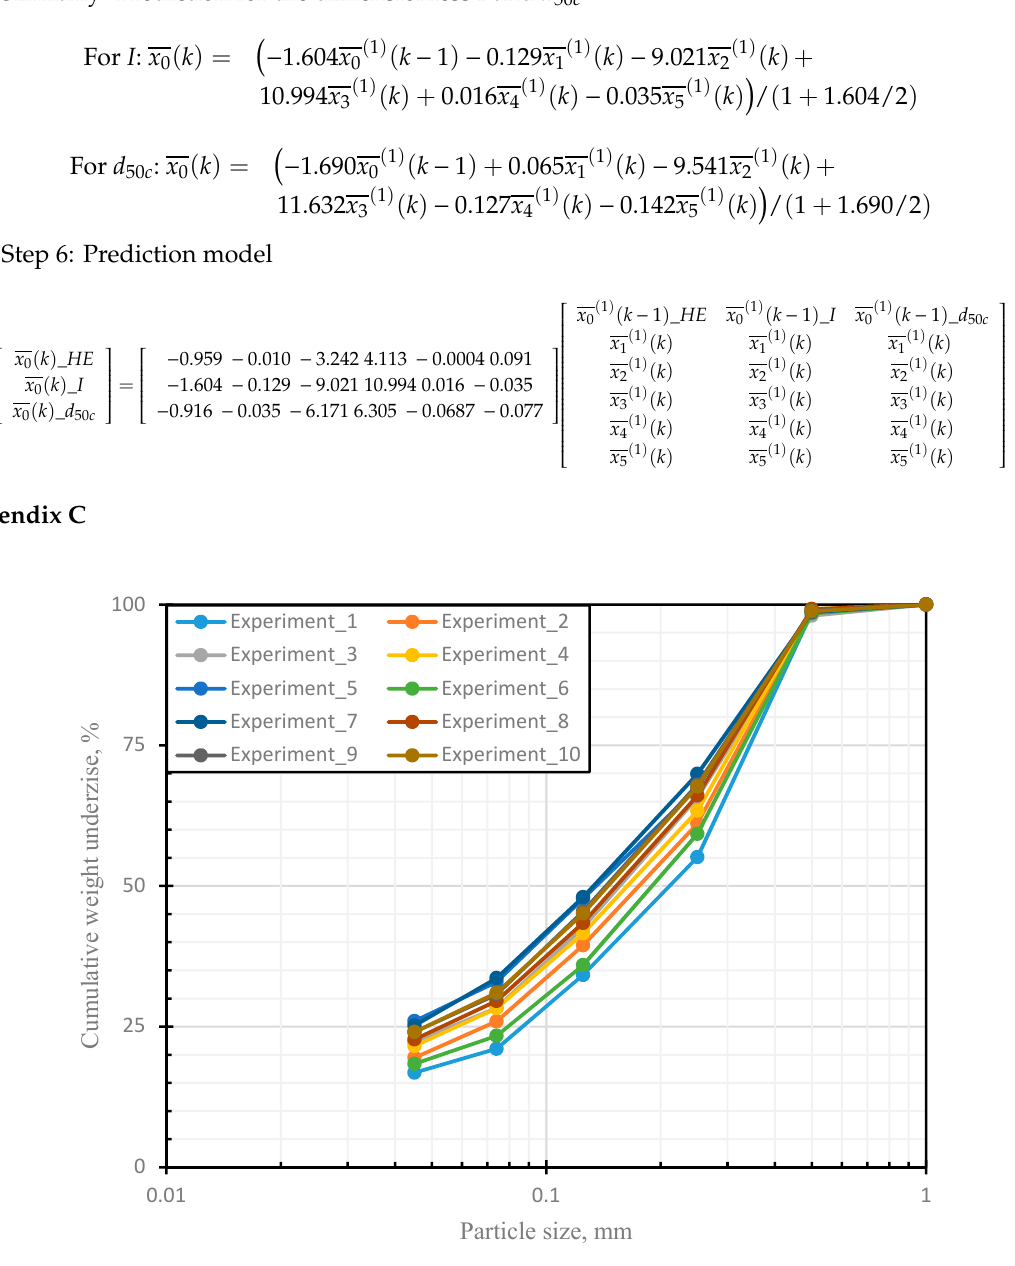
Figure A1. Size distribution of feed corresponding to each experiment for TPHS.